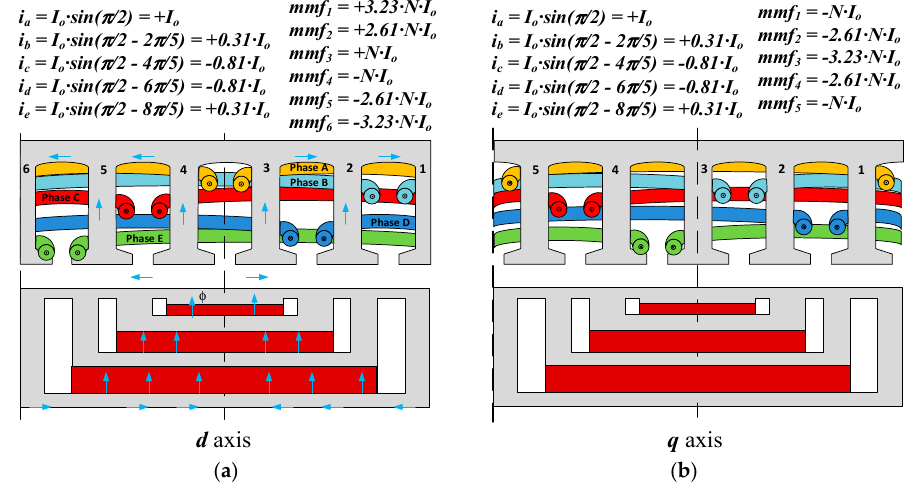
Figure 3. One pole of a five-phase fPMa-SynRM positioned in the direct ( d ) and quadrature ( q ) axes and the mmf distribution. ( a ) d -axis position. ( b ) q- axis position.